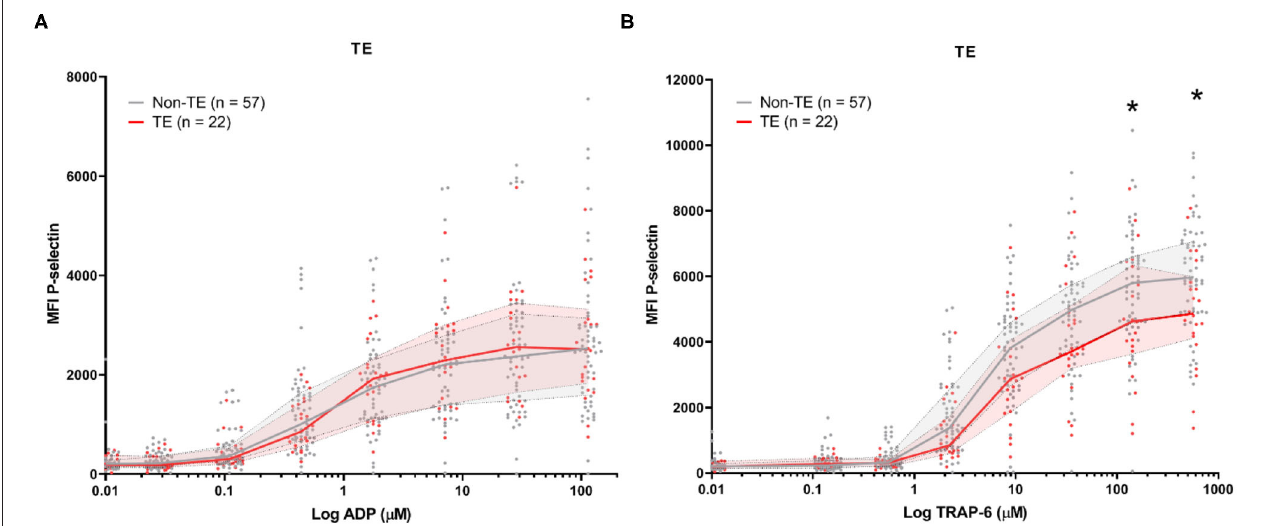
FIGURE 3 | COVID-19 patient platelet reactivity stratified by thrombotic events (TE). Median fluorescence intensity (MFI) of platelet P-selectin expression in response to ADP (A) , or TRAP-6 (B) . Data points represent individual values of patients that do not develop TE ( n = 57; displayed in gray) or do develop TE during hospitalization ( n = 22; displayed in red). The median value and interquartile range are indicated. Statistical difference was tested for all concentrations of agonist using one-way ANOVA with Sidak’s multiple comparisons test. * p <